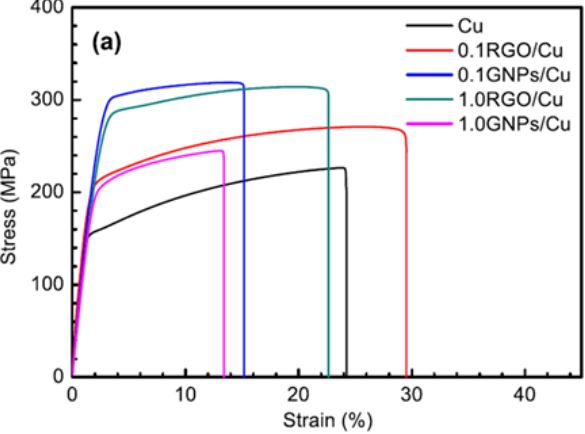
Figure 19: Tensile stress-strain behavior of GNP-Cu and rGO-Cu composites at different reinforcement content. Reproduced from Reference